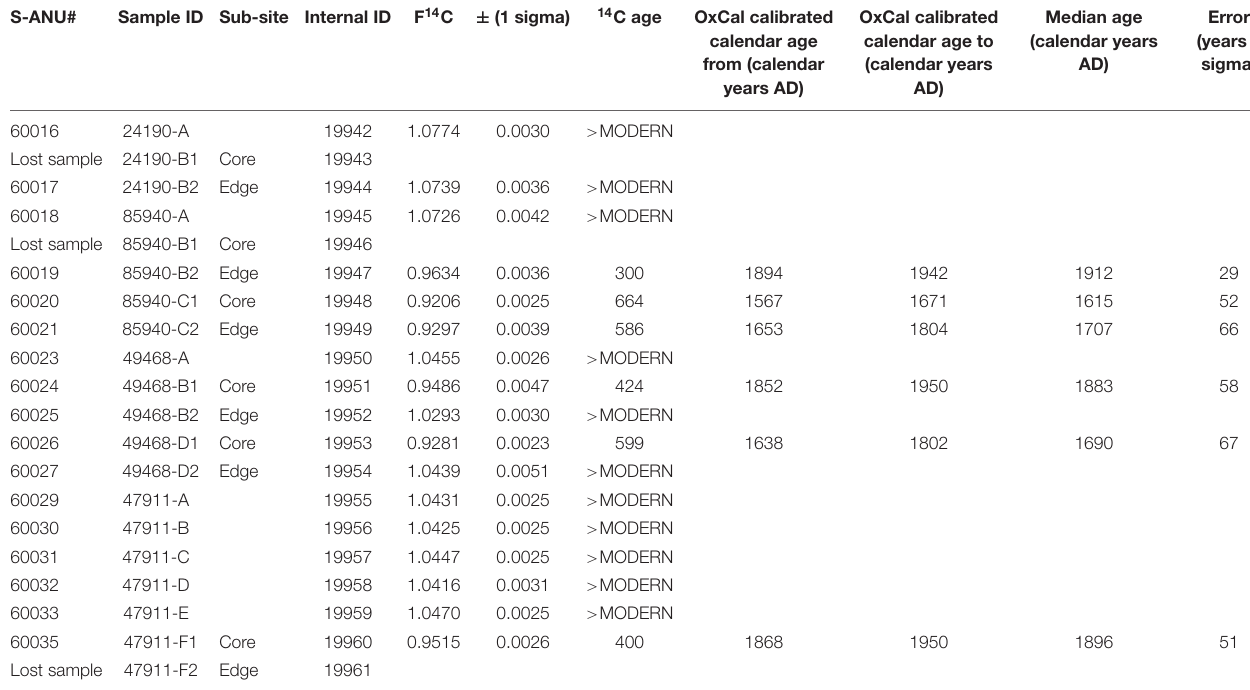
TABLE 3 | Radiocarbon results.